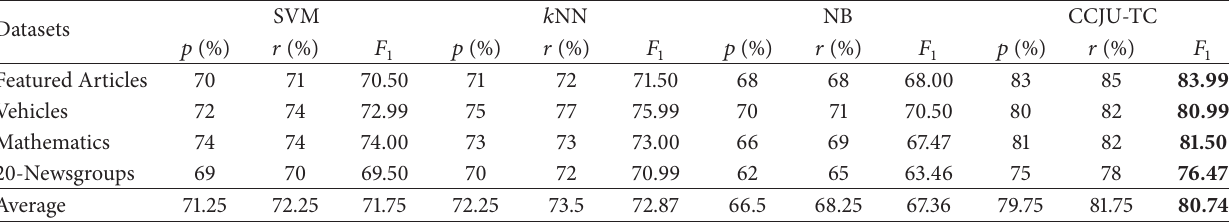
Table 3: Classification performance of different classifier with